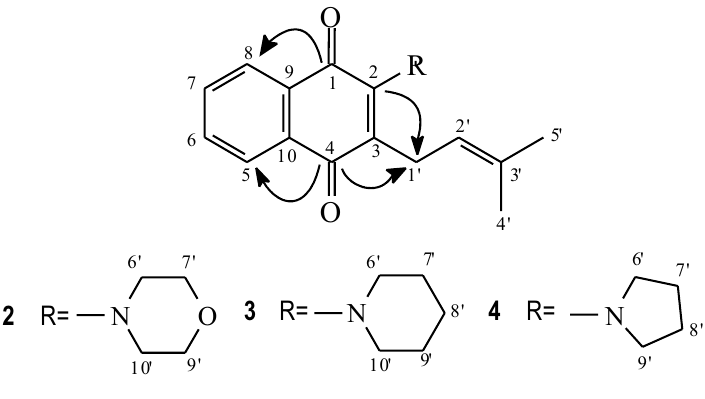
Fig. 3 – Selected HMBC correlations for compounds 1-4